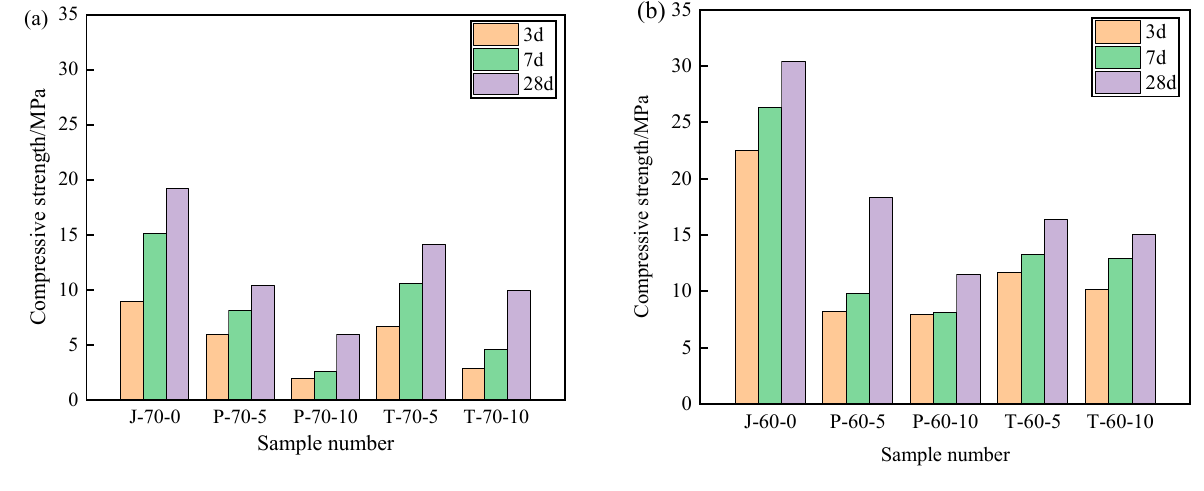
Figure 9. Compressive strength of recycled aggregate pavement bricks containing PEG-400/SiO 2 and Tet/SiO 2 composite shaped PCM: ( a ) 70% brick slag; ( b ) 60% brick slag.